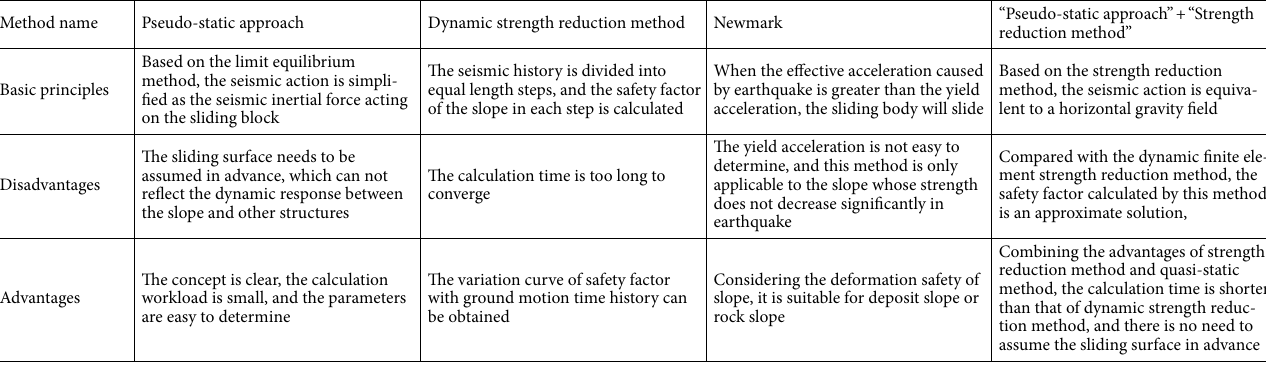
Table 1. Basic principle, advantages and disadvantages of slope dynamic stability analysis